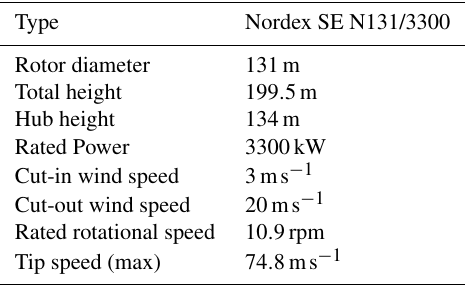
Table 1. Specifications of the wind turbines in the observed wind park during the measurement campaigns in 2019 and